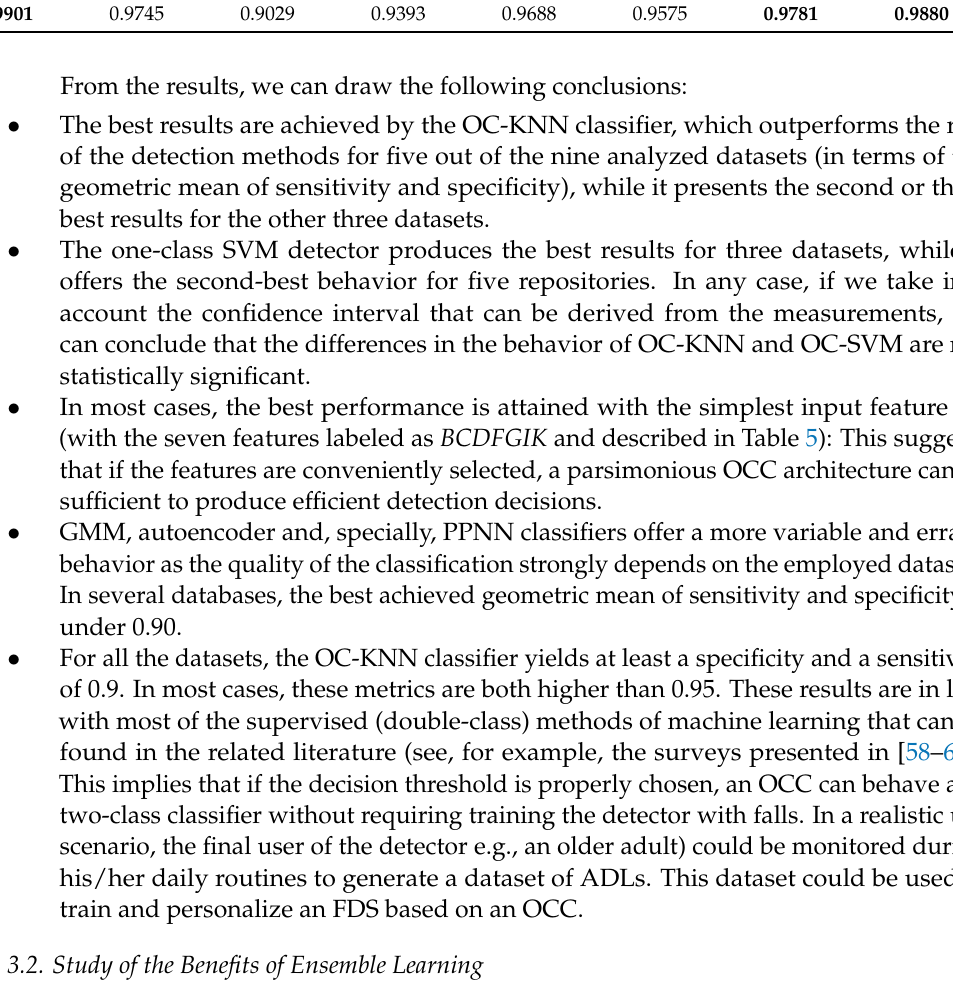
(cid:112) Se · Sp ) for the best combination of hyperpa-